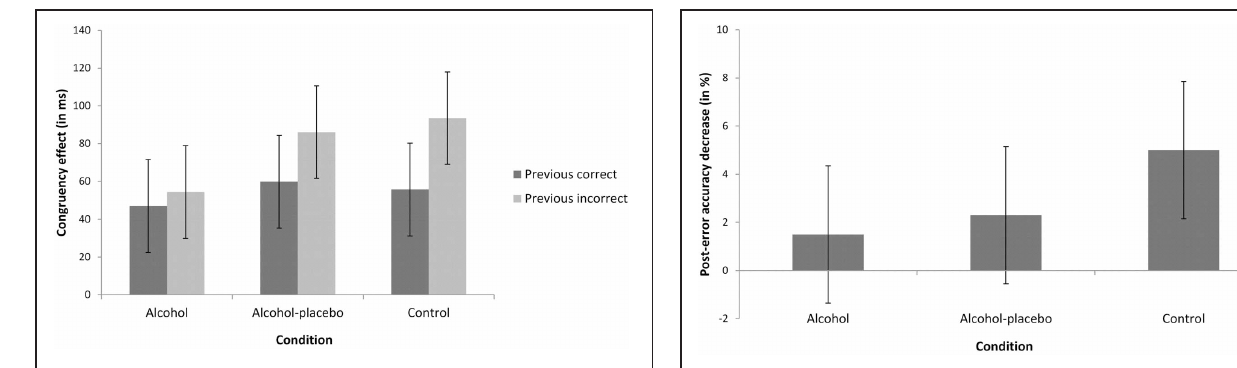
FIGURE 3 | Displays the difference in error rates (in %) between trials following incorrect and correct responses (with positive values indicating post-error accuracy decrease) for the alcohol, alcohol-placebo, and control group. Error bars represent 95% between-subjects confidence intervals (Loftus and Masson,